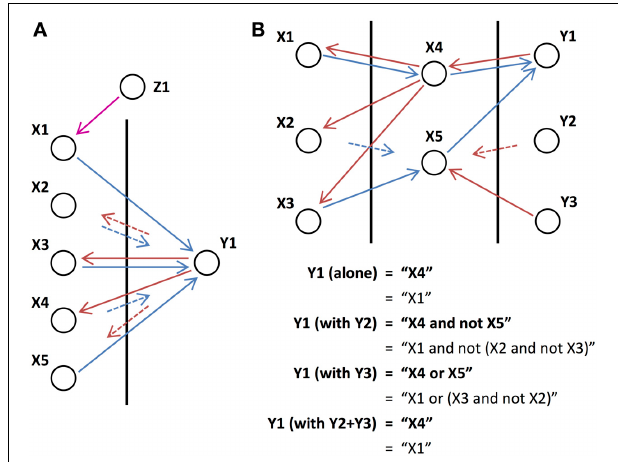
FIGURE 7 | Phase-dependent operations. (A) An output unit connected to the five input units, X1-X5, which receive orchestrating feedback from unit Z1 that is out-of-phase with the inputs, performs the operation “(X1 or X3) and not X4” when it is out-of-phase with the inputs and “X3 and not X1 and not X5” when it is in phase with the inputs. (B) The operation performed by output unit Y1 is changed depending on which other output (or external) units are initiated with it. Intermediate unit X5 is added by either Y2 or Y3 but in different ways, causing it to play a different role in the operation of Y1, and to perform different operations on its own inputs (X2 and